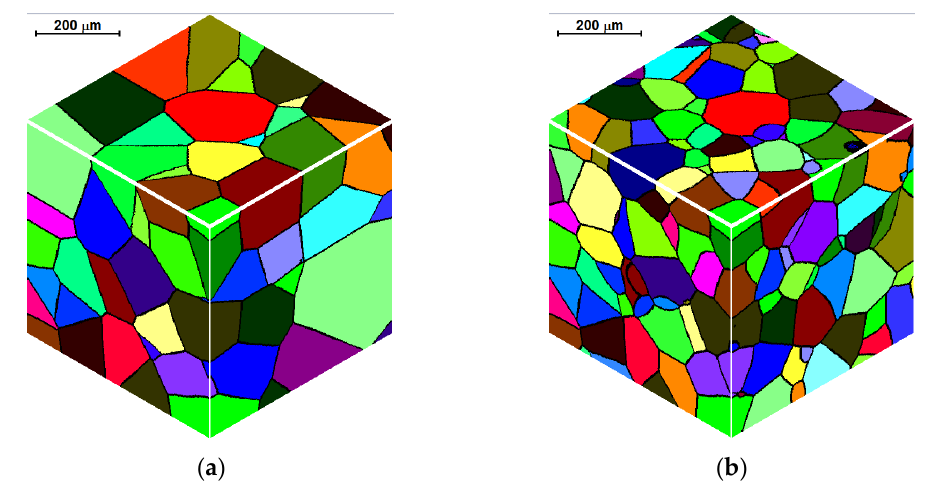
Figure 4. Initial microstructure with semi-open ( a ) and full-open ( b ) boundary conditions.